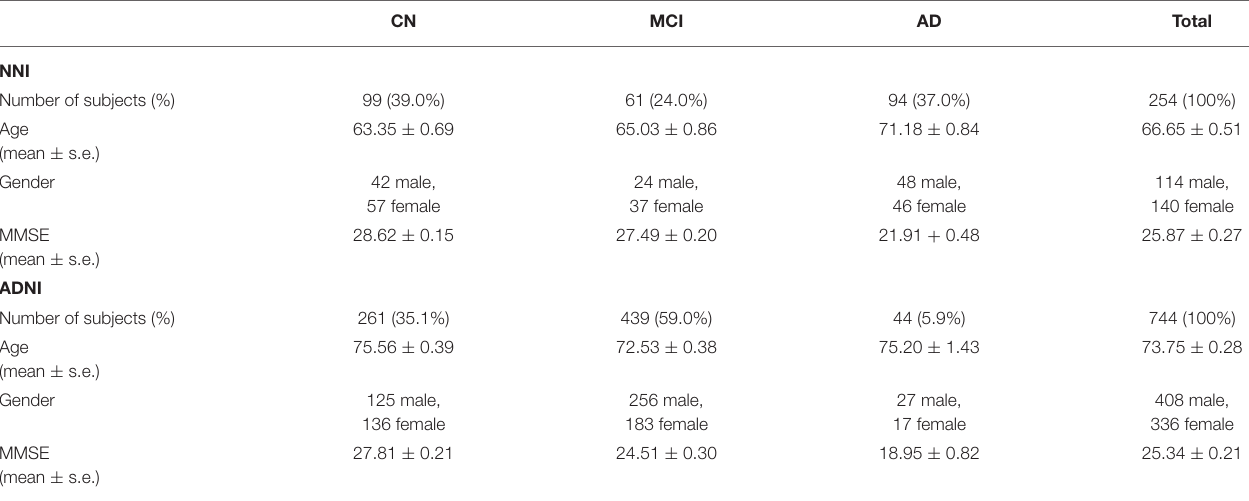
TABLE 1 | Demographics and Mini-Mental State Examination (MMSE) scores of cognitively normal (CN) controls, mild cognitive impairment (MCI), and Alzheimer’s Disease (AD) subjects in the Alzheimer’s Disease Neuroimaging Initiative (ADNI) and National Neuroscience Institute (NNI)